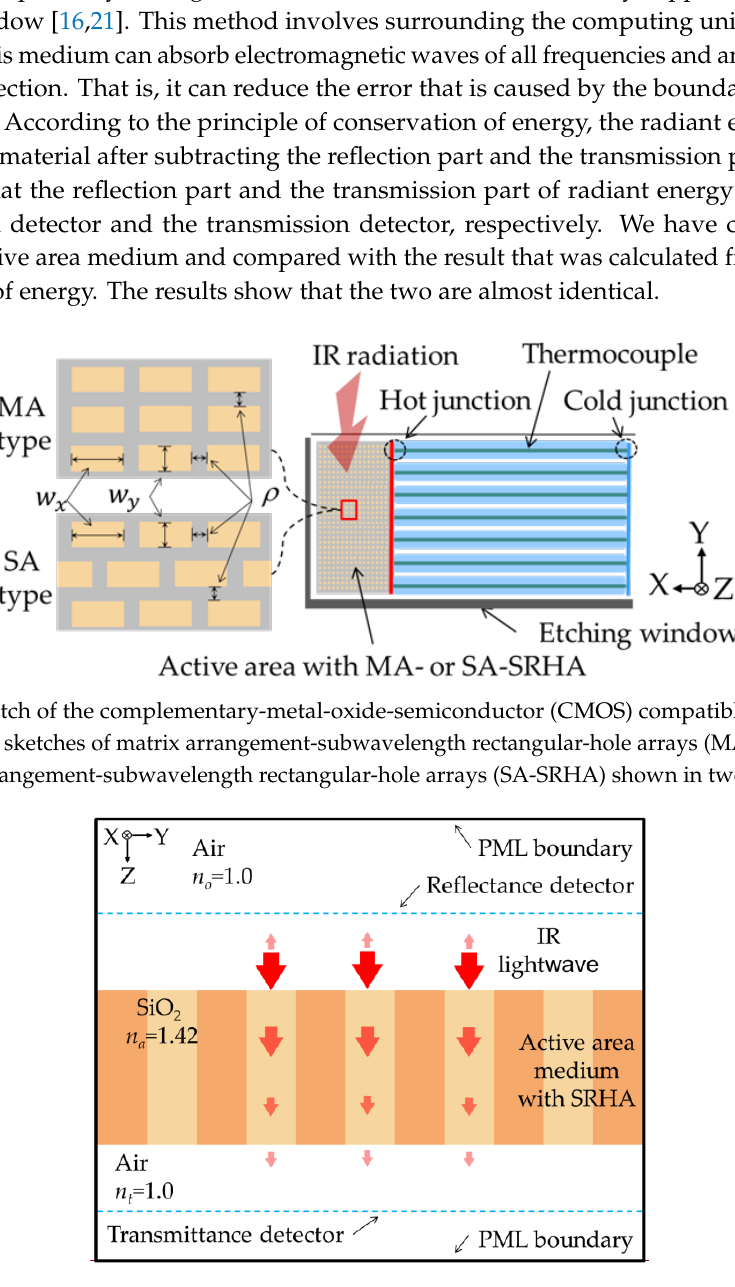
Figure 2. Sketch of a light-wave propagation through a CMOS compatible thermopile with SRHA simulated by the finite-difference time-domain (FDTD) method.